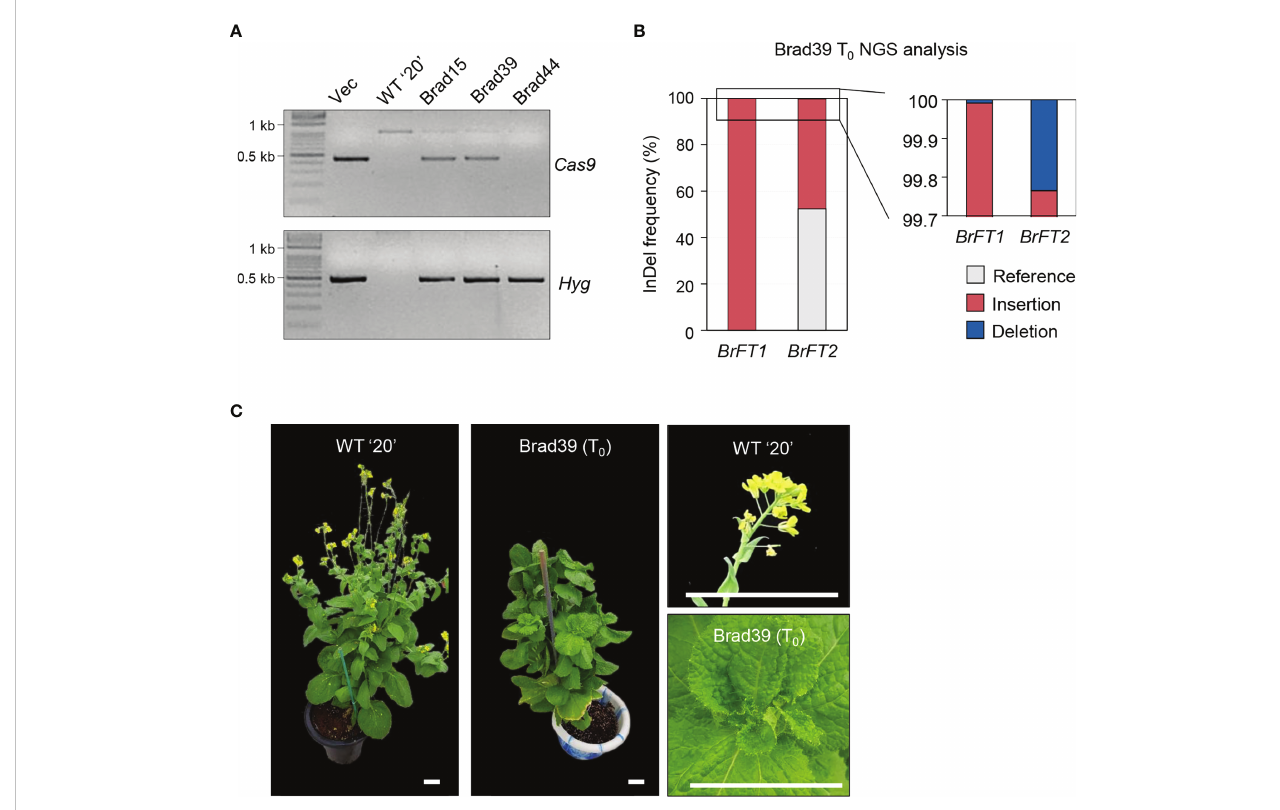
FIGURE 4 Generation of CRISPR/Cas9-mediated gene-edited plants for both BrFT1 and BrFT2 in Chinese cabbage inbred line ‘ 20 ’ and associated fl owering phenotypes. (A) Screening of T 0 plants. PCR was performed to identify BrFT1/2 -edited Chinese cabbage plants. (B) Analysis of Brad39 (T 0 ) plant by whole-genome sequencing. Percentage represents the proportion of reference and InDel (insertion/deletion) alleles at the target loci. Sequence alignments between the WT and mutants are shown in Figure S4B. (C) Bolting phenotype of WT ( ‘ 20 ’ inbred line) and a genome-edited Brad39 (T 0 ) plant. The photographs to the right show the fl ower buds (20) or the main stem still producing leaves (Brad39) at the same age. Scale bars, 5